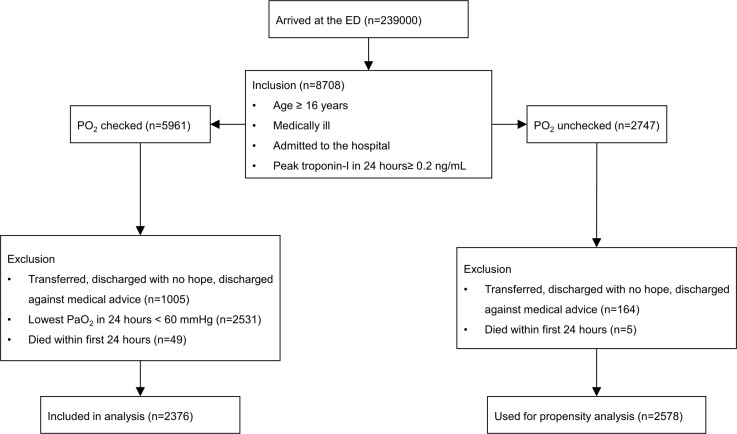
Flowchart of the inclusion and exclusion processes.